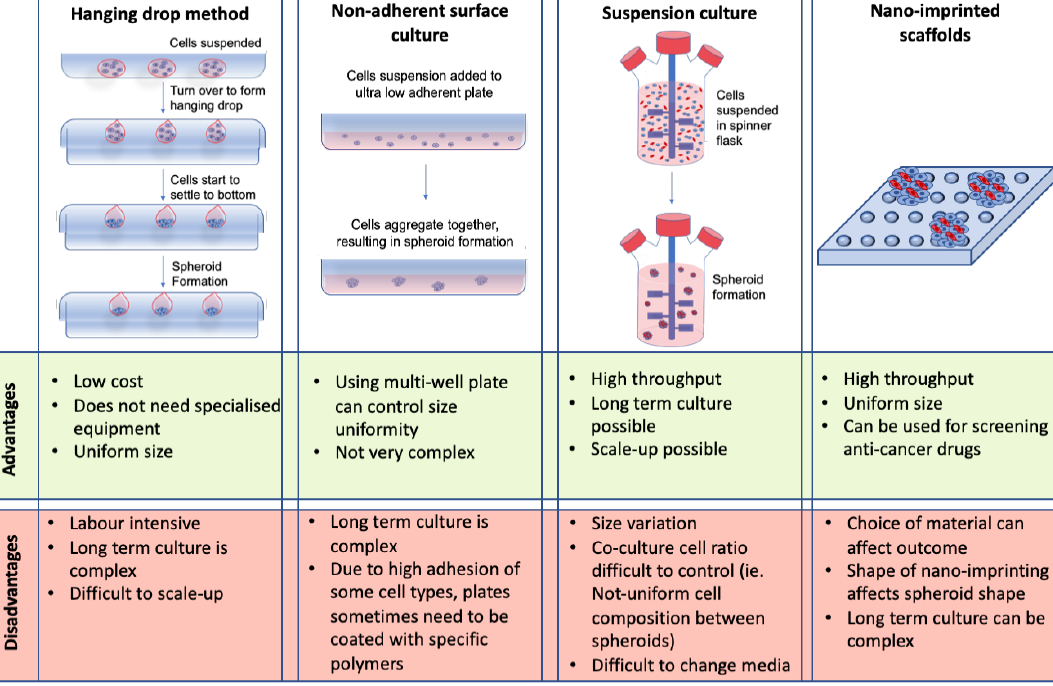
Figure 3. Advantages and disadvantages of spheroids as a 3D culture model. Different methods for spheroid formation, including their respective advantages and limitations, are shown including the hanging drop method, non-adherent surface culture, suspension culture, and nano-imprinted scaffolds [98–106] .